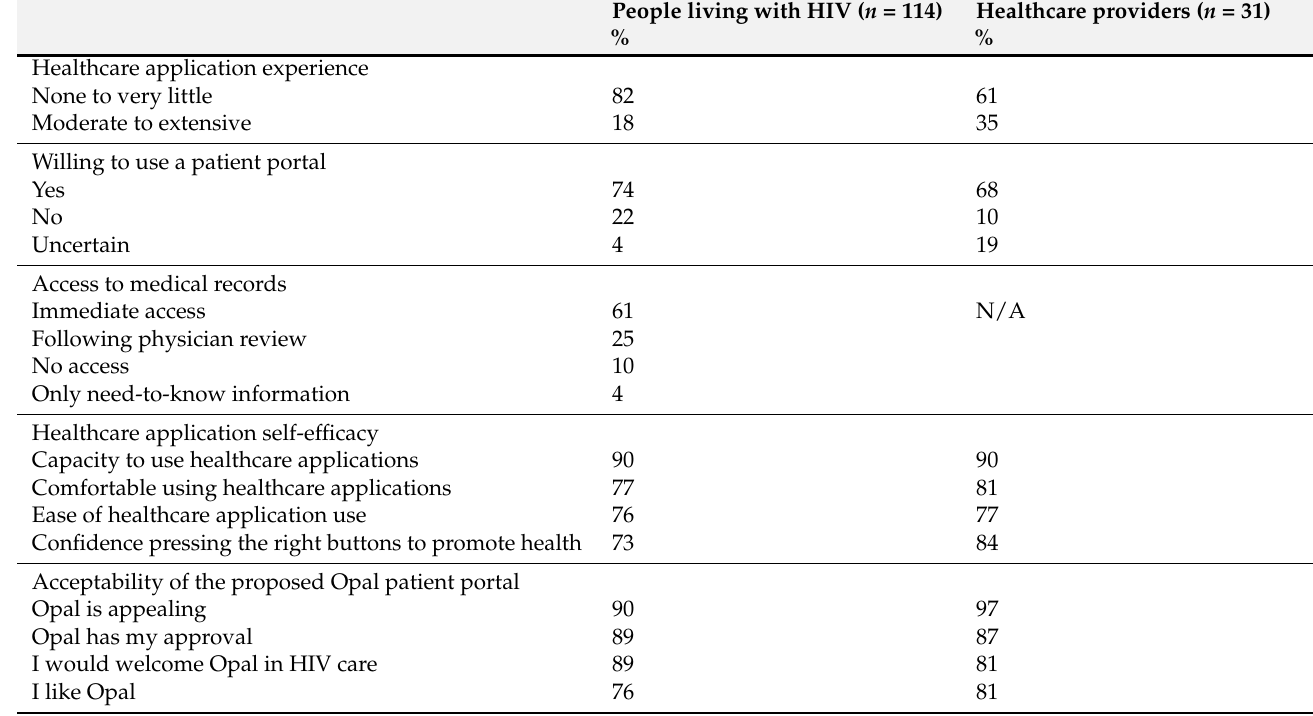
Table 2. Participants’ healthcare application experience, willingness to use a patient portal, preferences for accessing medical records, healthcare application self-efficacy, and acceptability of